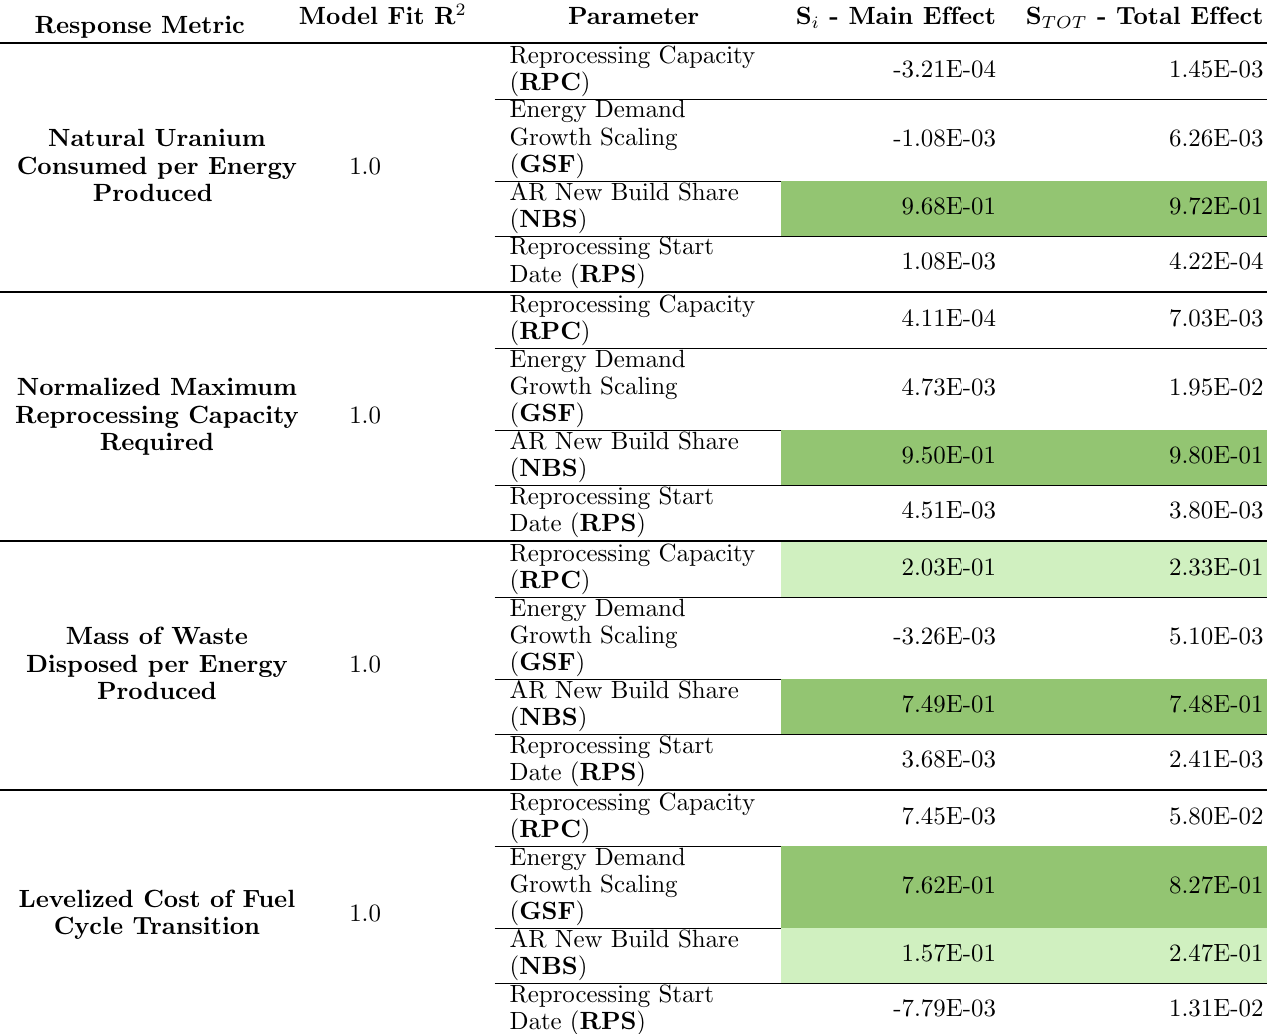
Table 5. Main effect indices and total effect indices for the Gaussian process surrogate model. Response